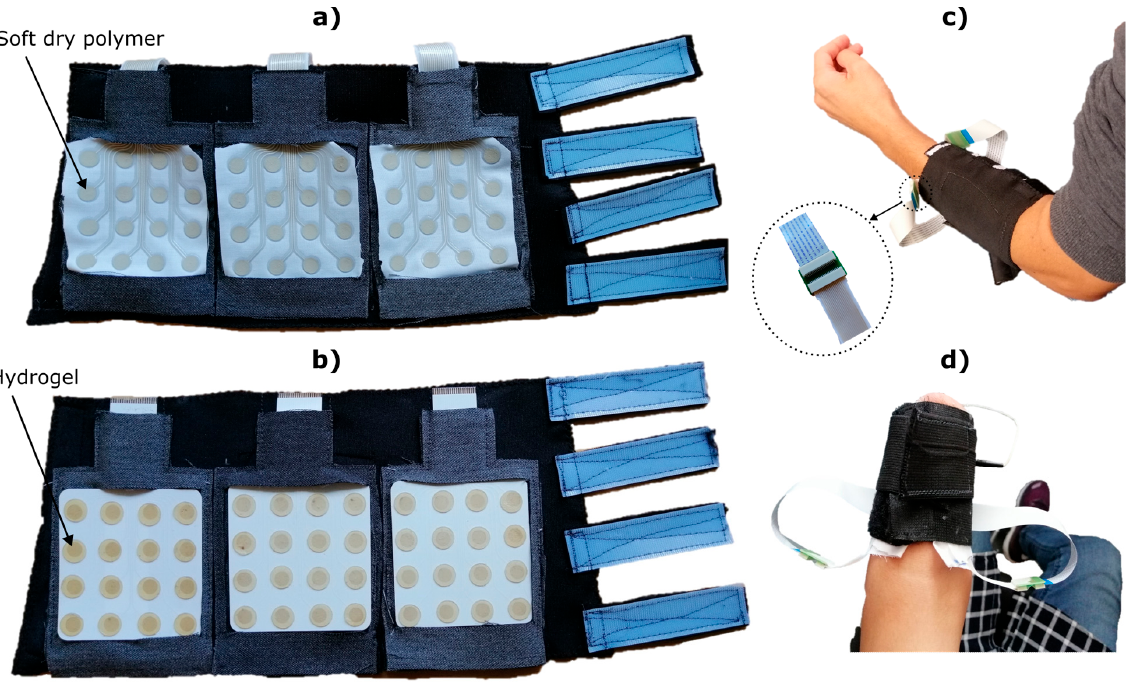
Figure 7. Sample armbands used to record EMG signals for offline analysis and online control. ( a ) Three TEX matrices placed in the garment. The exposed pads of the matrix were coated with a highly conductive soft polymer, as described in Section 2.1.1. ( b ) Three PET matrices placed in the garment. Round hydrogel discs were applied to each recording pad as electrode-skin interface. ( c ) An able-bodied participant wearing the armband. Encircled is a detail view of the connection between the textile and the flexible cables using a double-sided ZIF adaptor. ( d ) Transradial amputee wearing a custom-made elastic armband with the TEX electrodes adapted to the size of the residual limb.